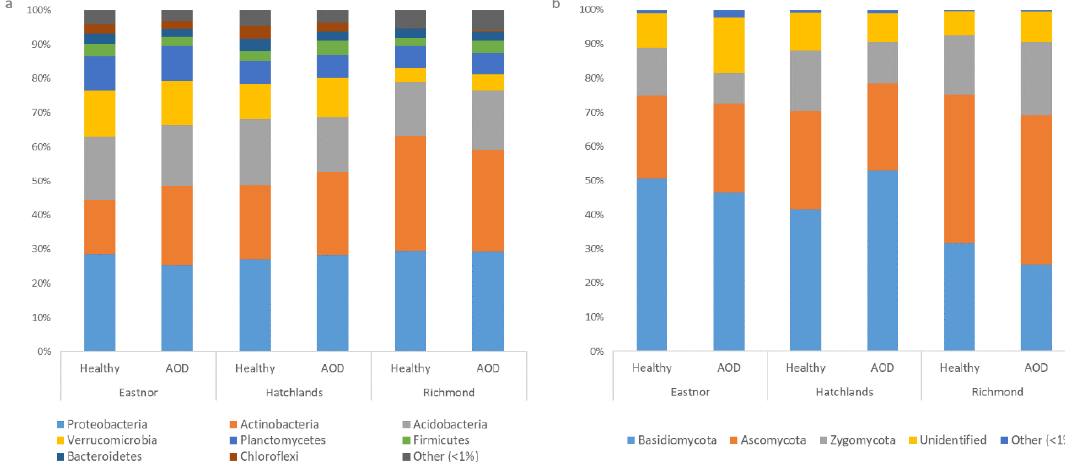
Figure 2. Relative abundance of the bacterial ( a ) and fungal ( b ) phyla detected in the rhizosphere of the healthy and AOD trees in Eastnor Park, Hatchlands Park, and Richmond Park ( n = 24). The phyla that individually represented less than 1% of the total community were grouped in the artificial group